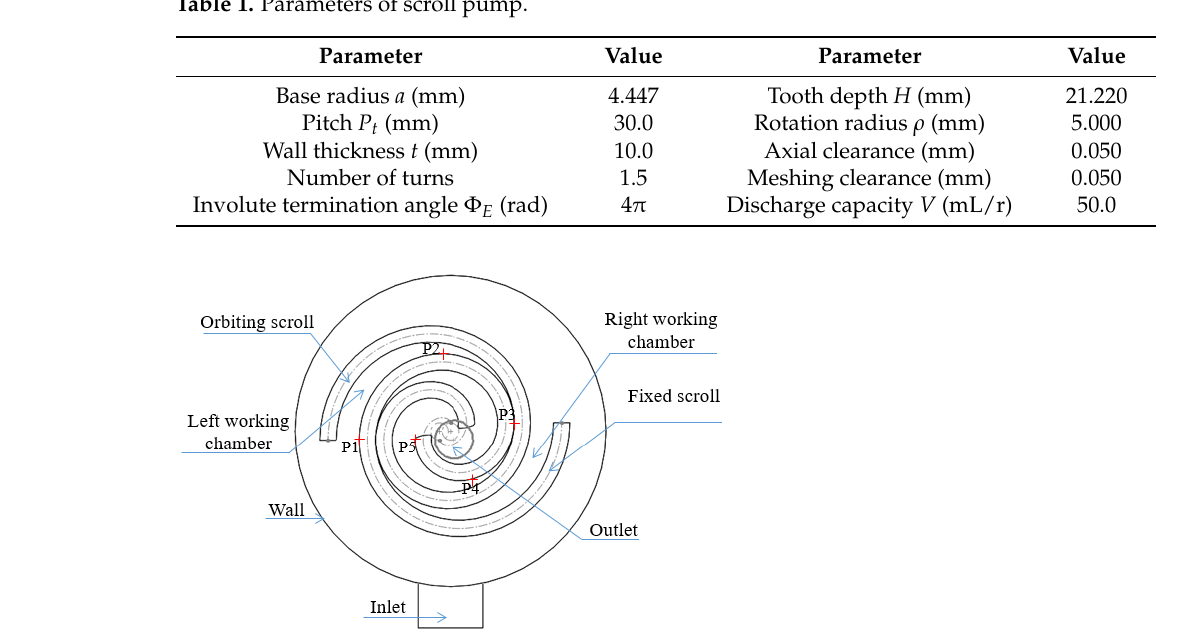
Table 1. Parameters of scroll pump.